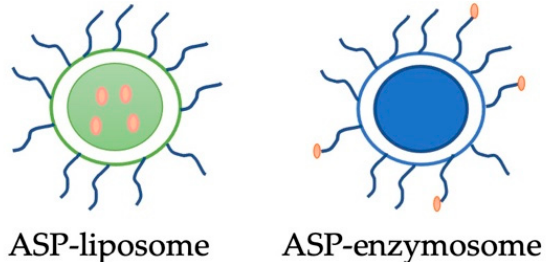
Figure 1. Representation of asparaginase encapsulated into PEG-liposome (ASP-liposome) and attached to PEG molecules at the liposome surface (ASP-enzymosome).